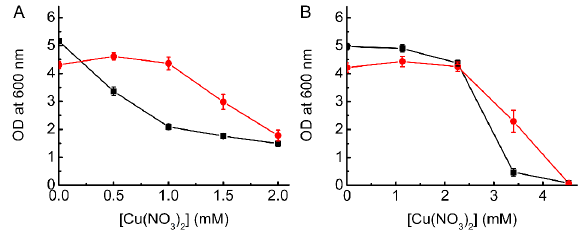
Figure 3. The influence of Bs Csp3 expression on the growth of Δ copA and WT E. coli in Cu. Growth (37 °C) after 12 h for Δ copA ( A ) and WT ( B ) E. coli plus pBAD33_ Bscsp3 (red circles) and pBAD33 (black squares) in LB media plus 0.2% L ‐ arabinose in the presence of increasing concentrations of added Cu(NO 3 ) 2 . Average OD values and standard deviations from three independent experiments are shown, and the growth curves are available in Figures S4 and S6, respectively.